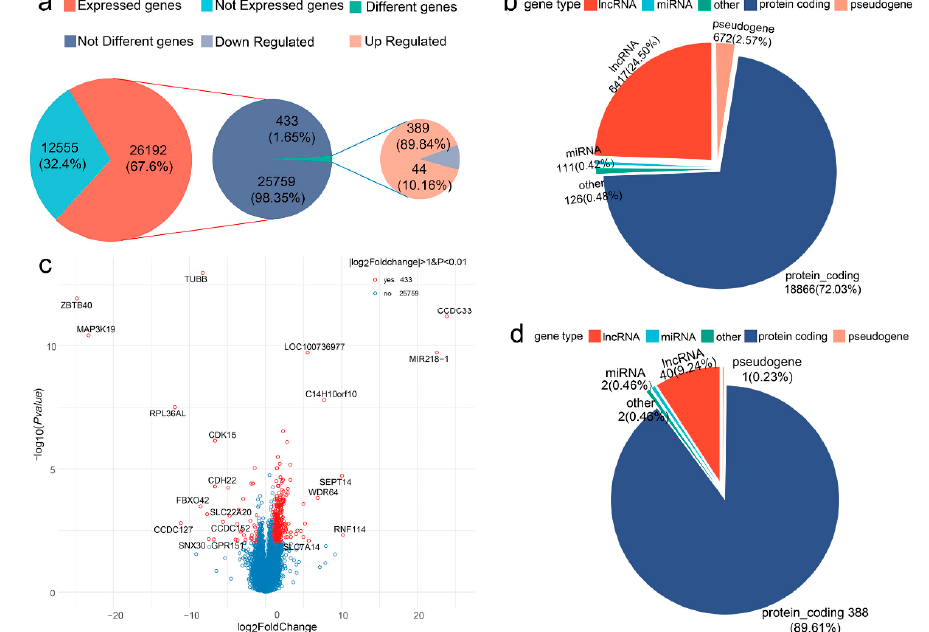
Figure 2. Counting and classification of differentially expressed genes (DEGs). ( a,b ) The pie chart displays the DEGs distribution among protein coding genes, long non-coding RNA (lncRNA), pseudogene, microRNA (miRNA), and other gene types. ( c ) Volcano plot of the DE genes with |log2(FoldChange)| > 1 and adjusted p- value < 0.01. The log2 Fold Change on the x-axis signifies expression di ff erence, while the − log10 ( p- value) on the y-axis indicates the significance of each gene. Red dots represent the 433 DE genes. Blue dots represent the remaining detected genes that did not meet the determined criteria. Dots with gene name annotations signify the 20 most significant DE genes. ( d ) The pie chart displays the distribution of 433 DE genes among protein coding genes, lncRNA, pseudogene, miRNA, and other gene